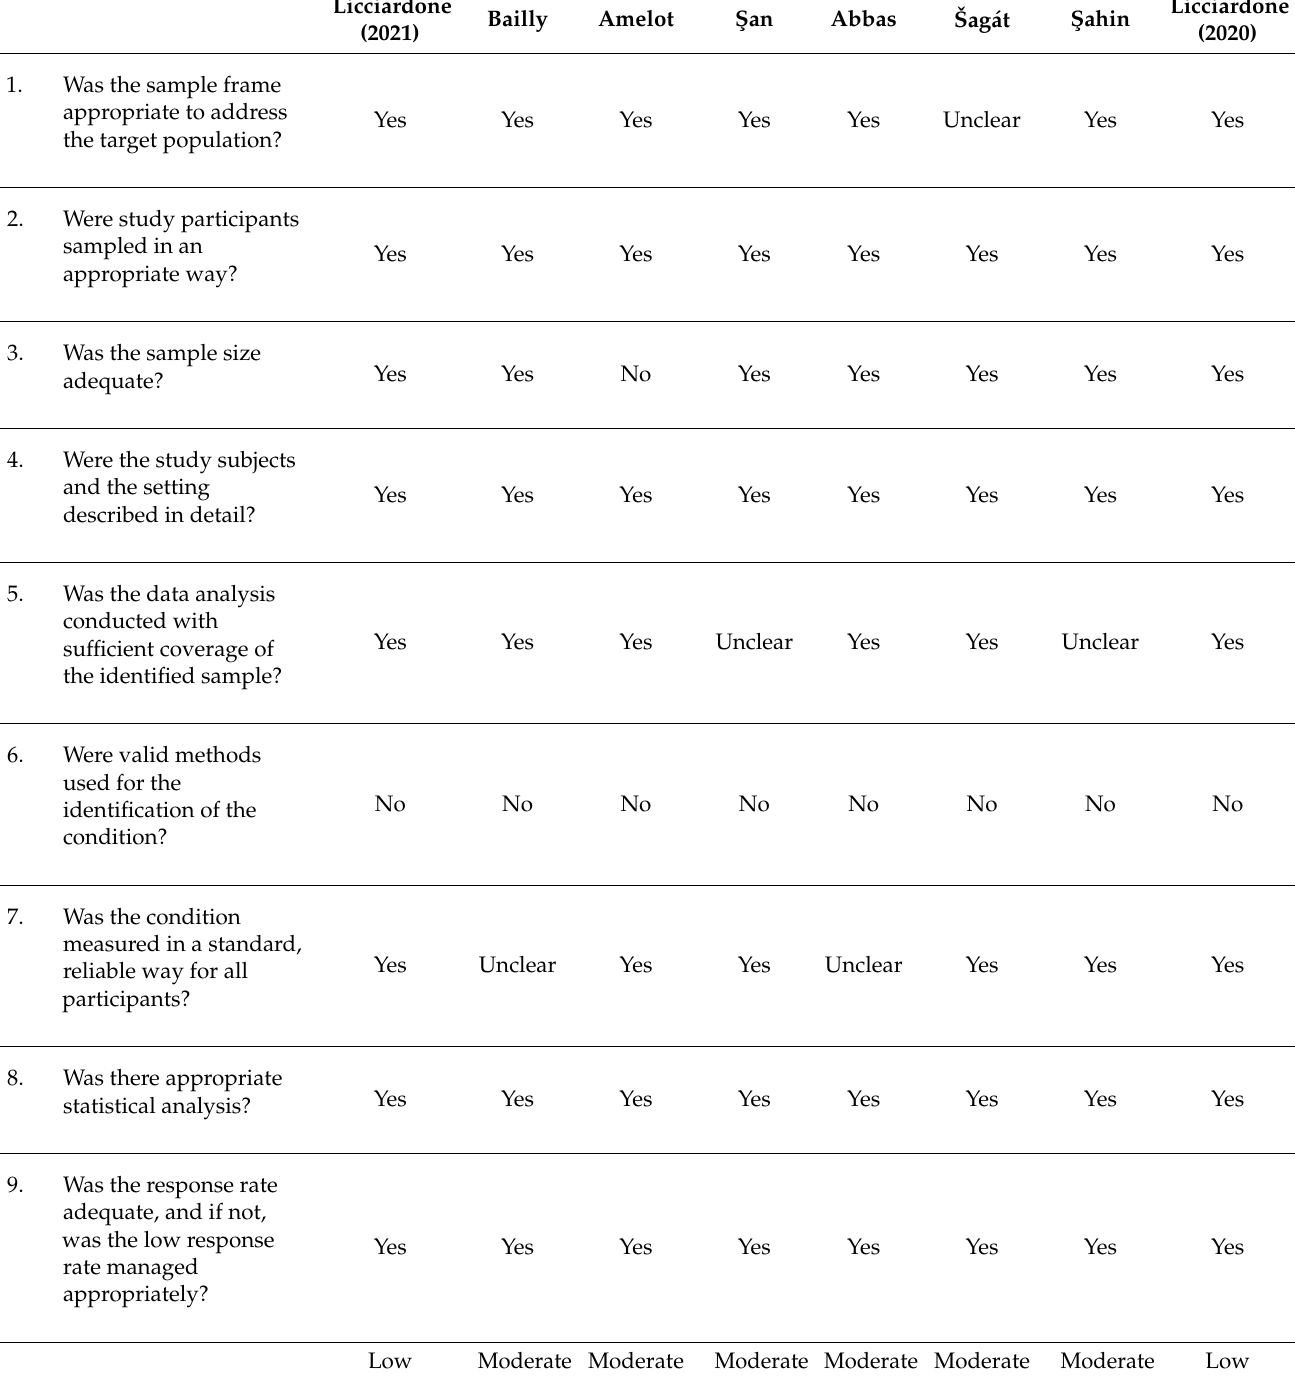
Table 2. JBI checklist for prevalence